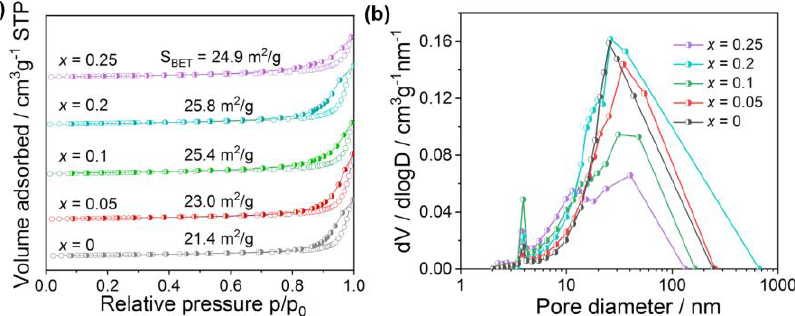
Figure 3. N 2 adsorption—desorption isotherms ( a ) and pore size distribution ( b ) of La 1- x Ce x MnO 3 (0 ≤ x ≤ 0.25) catalysts.